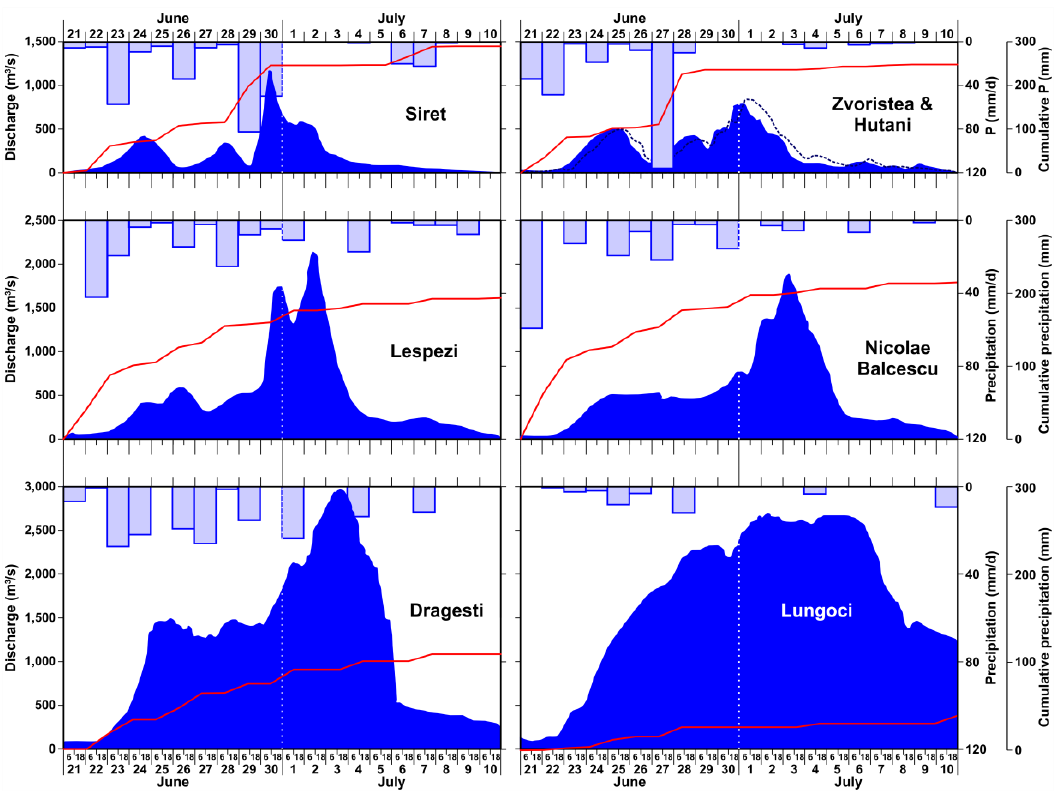
Figure 10. Hydrograph of flood waves and daily intensity of precipitation between 21 June and 10 July 2010, recorded at the hydrometric stations on the Siret River.